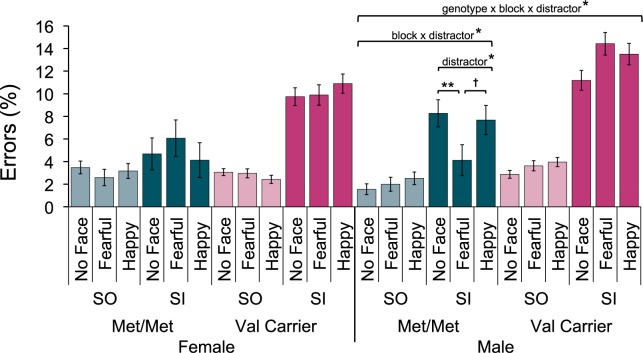
Four-way interaction of block type, distractor type, COMT genotype and sex on mean PE in the Emotional Alphabet task (Mean ± 1 SE). Follow-up repeated measures ANOVAs indicate that male Met/Met participants made fewer errors when exposed to a fearful face distractor, specifically in SI blocks (**P < 0.01, *P < 0.05, †P < 0.1).